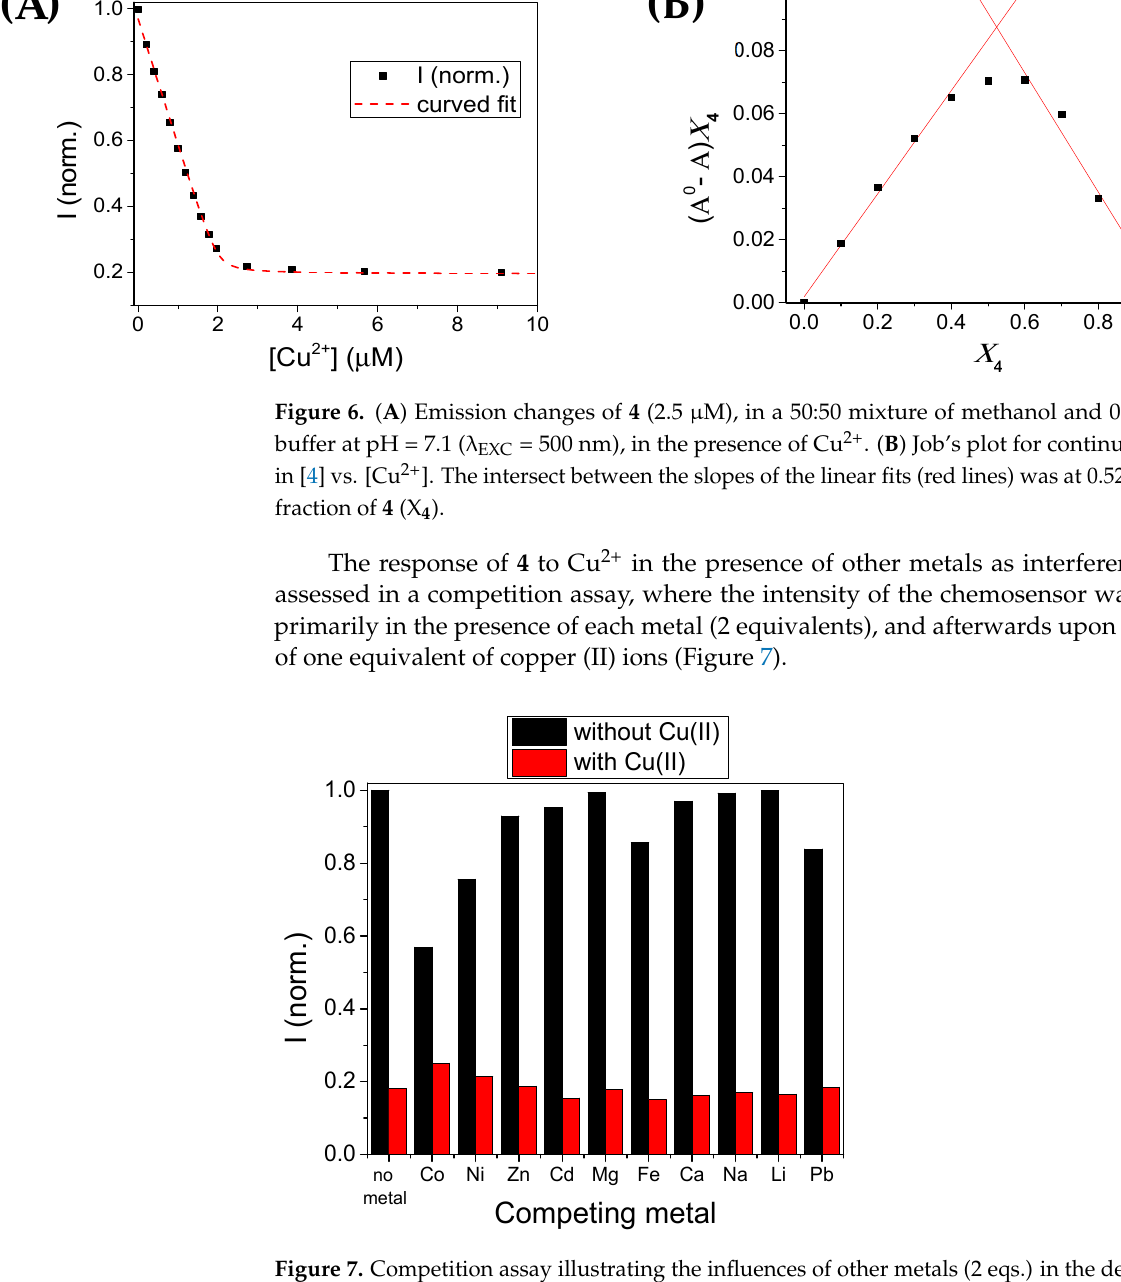
Figure 7. Competition assay illustrating the influences of other metals (2 eqs.) in the detection of one equivalent of Cu 2+ ions (1 eq.), in a 50:50 mixture of methanol and 0.01 M HEPES buffer at pH = 7.1 ( λ EXC = 500 nm).